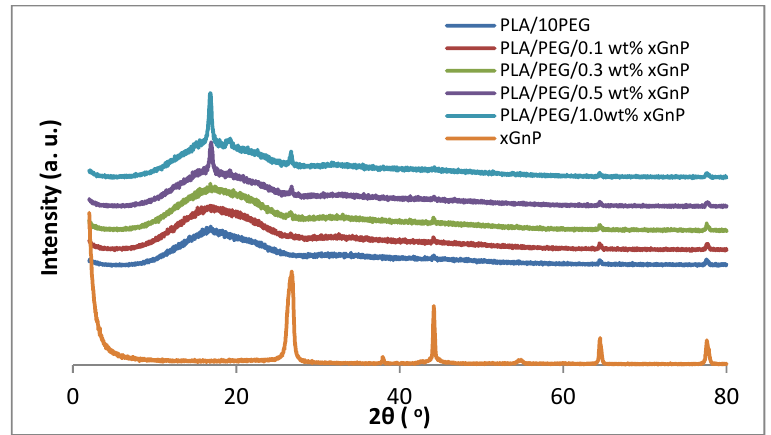
Figure 2. X-ray diffraction (XRD) patterns of graphene nanoplatelets (xGnP), PLA/PEG, and PLA/PEG nanocomposites.